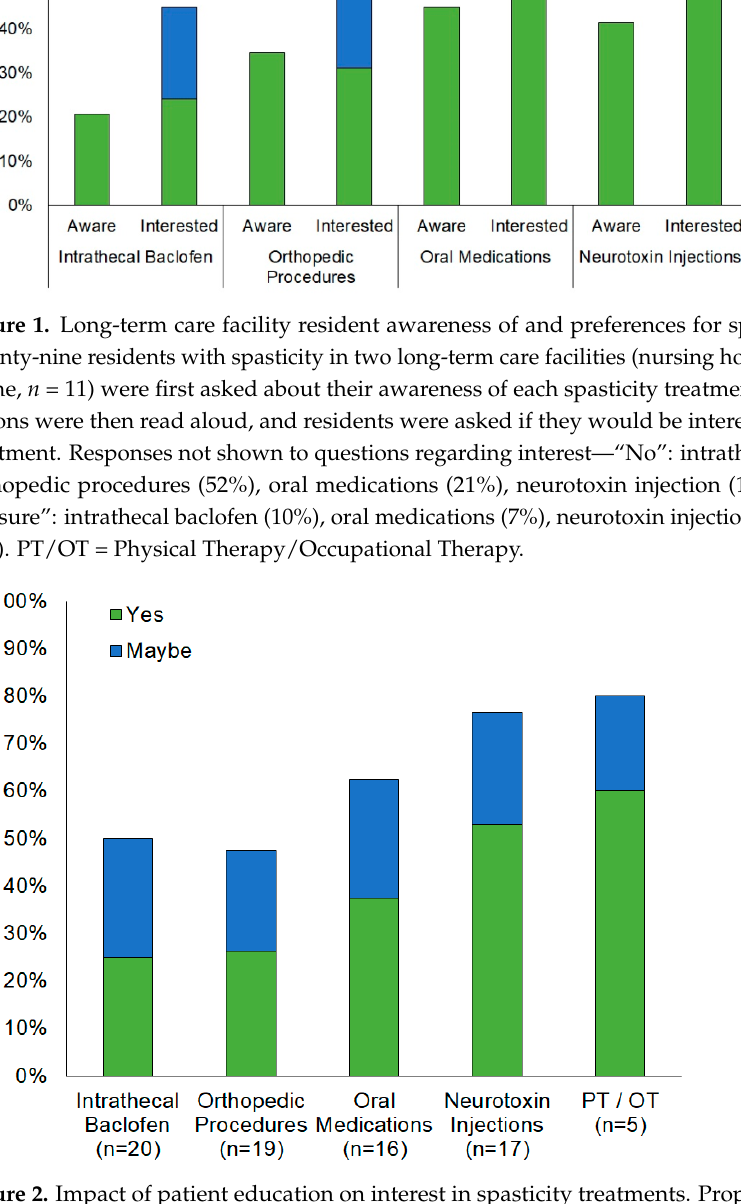
Figure 2. Impact of patient education on interest in spasticity treatments. Proportions of residents previously unaware of spasticity treatments ( n ) who subsequently indicated interest (Yes) or potential interest (Maybe) in receiving treatments after learning about them. Responses not shown to questions regarding interest—“No”: intrathecal baclofen (50%); orthopedic procedures (53%); oral medications (25%); neurotoxin injections (18%); PT/OT (20%); “Unsure”: oral medications (13%); and neurotoxin injections (6%).